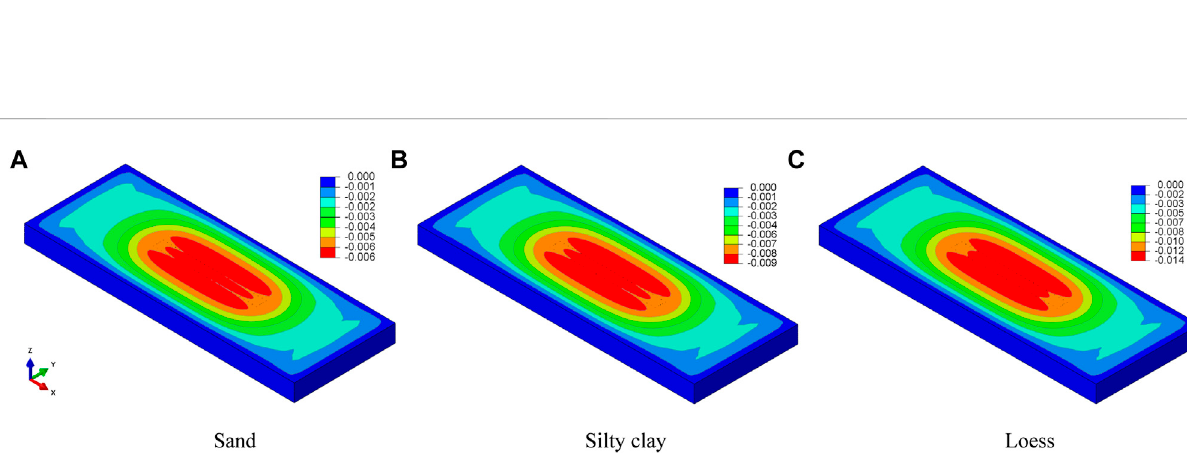
Frontiers in Earth